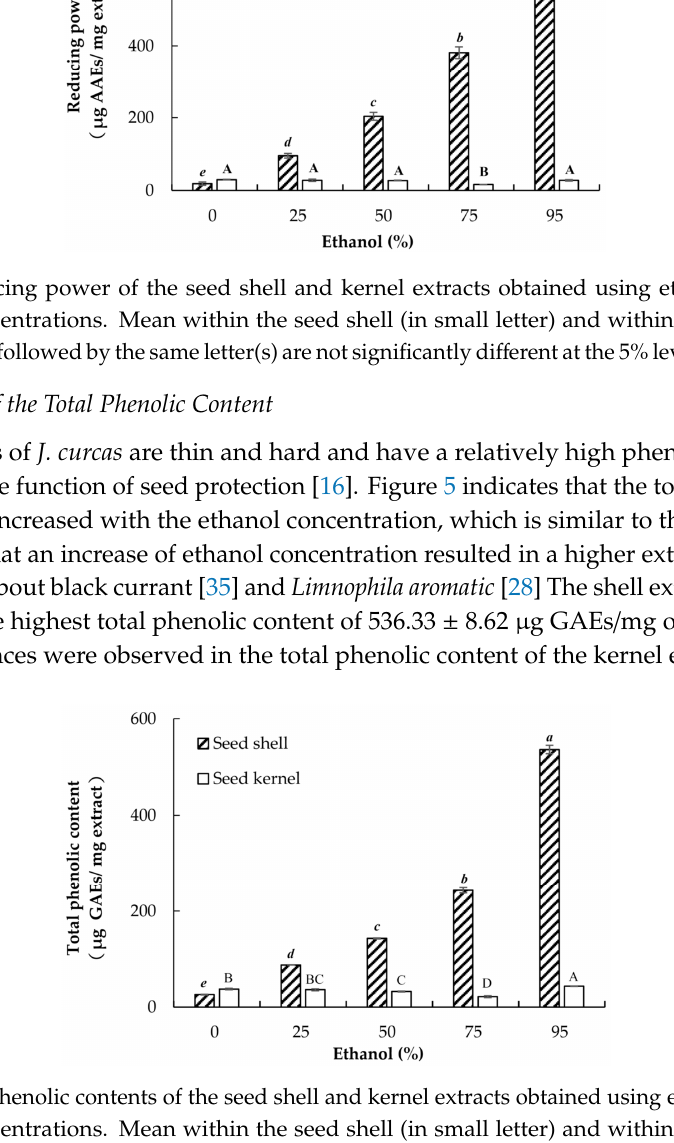
Figure 5. Total phenolic contents of the seed shell and kernel extracts obtained using ethanol solutions of different concentrations. Mean within the seed shell (in small letter) and within the seed kernel (in capital letter) followed by the same letter(s) are not significantly different at 5% level by Tukey test.